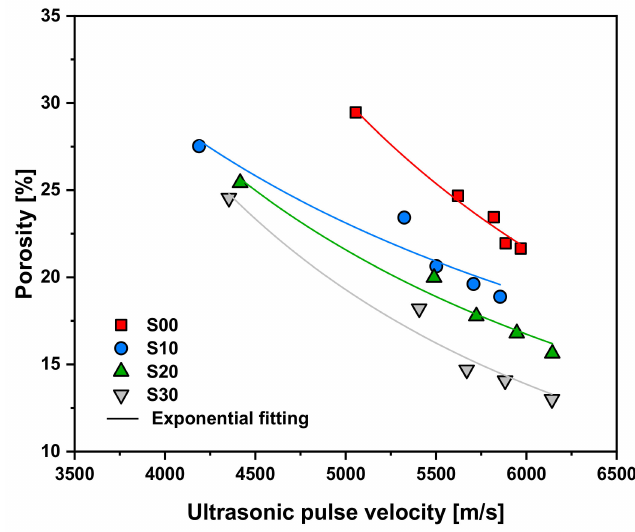
Figure 12. Correlation between UPV and porosity according to the replacement rate of